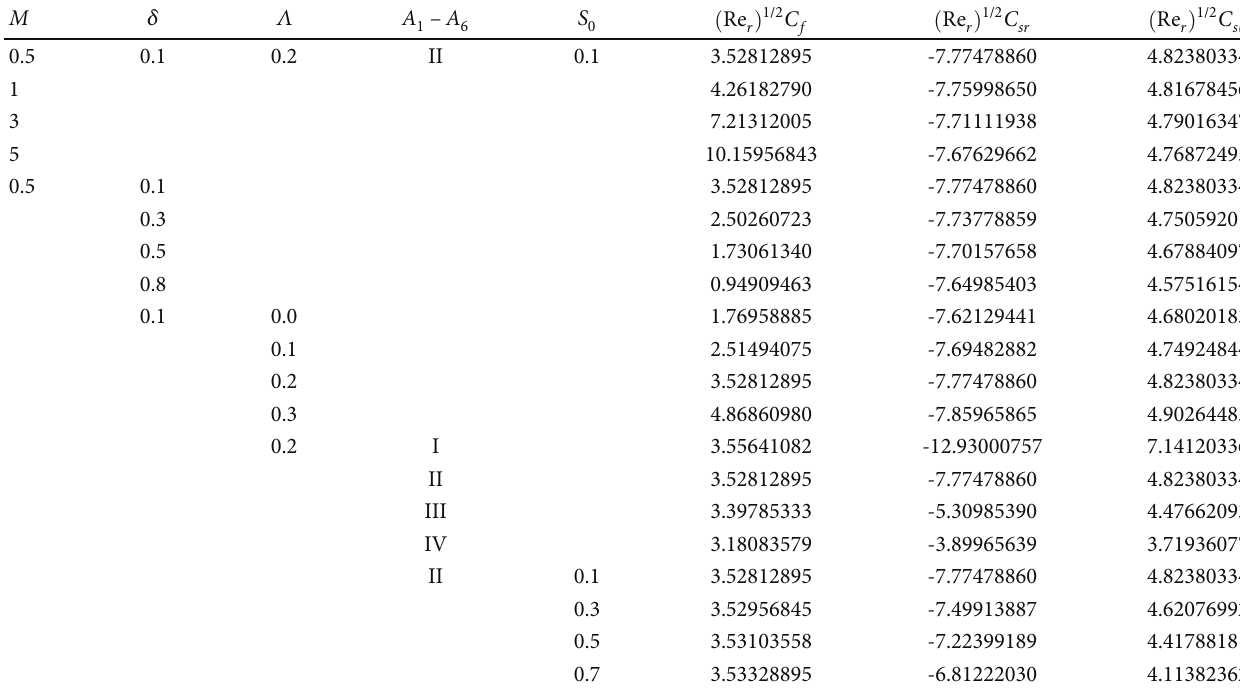
= 0 : 2 , α = 0 : 2 , Bi = 0 : 5 t c